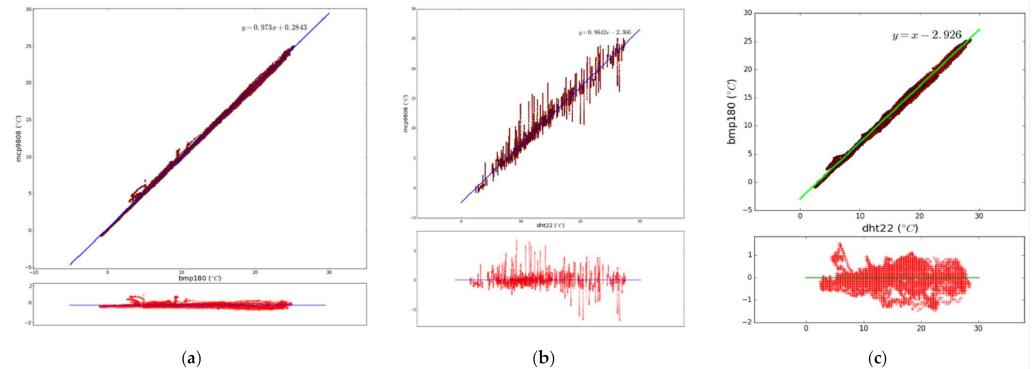
Figure 7. Regression line and residuals for temperature values of MCP9808 and BMP180 sensors ( a ), MCP9808 and DHT22 ( b ), and BMP180 and DHT22 sensors ( c ).